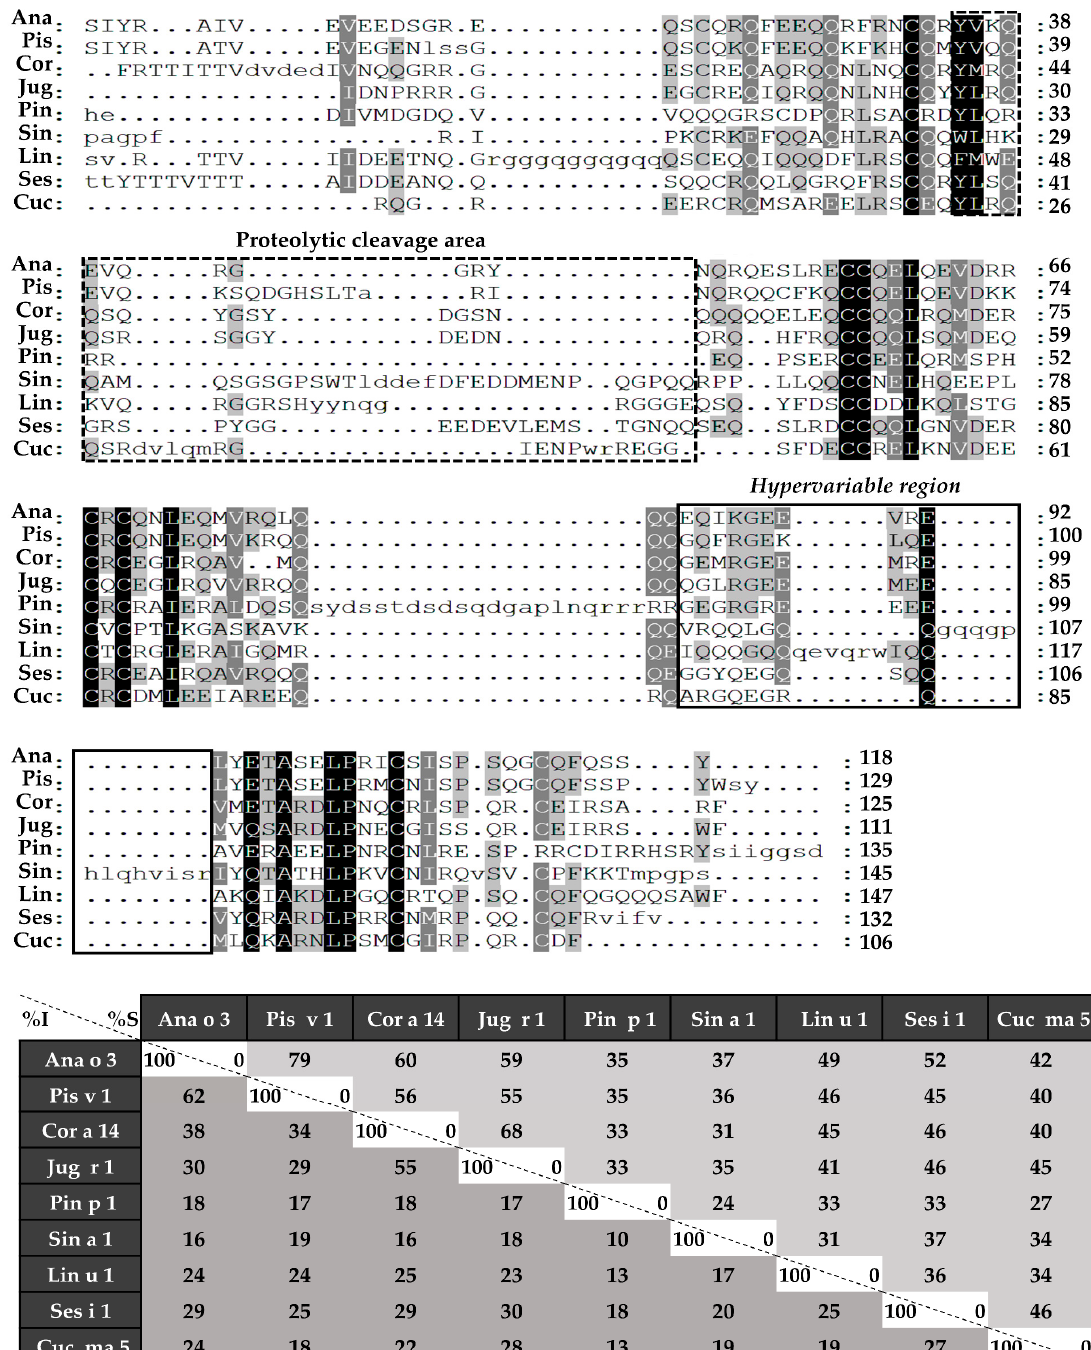
Figure 4. Sequence alignment of isolated 2S albumins. Primary structures of 2S albumins were aligned with ClustalW online tool. The table under alignment shows percentages of identity (% I, dark grey) and similarity (% S, light grey) between the different proteins. Discontinuous line boxes indicate the proteolytic cleavage area between light and heavy chains, while continuous line boxes indicate the hypervariable region.